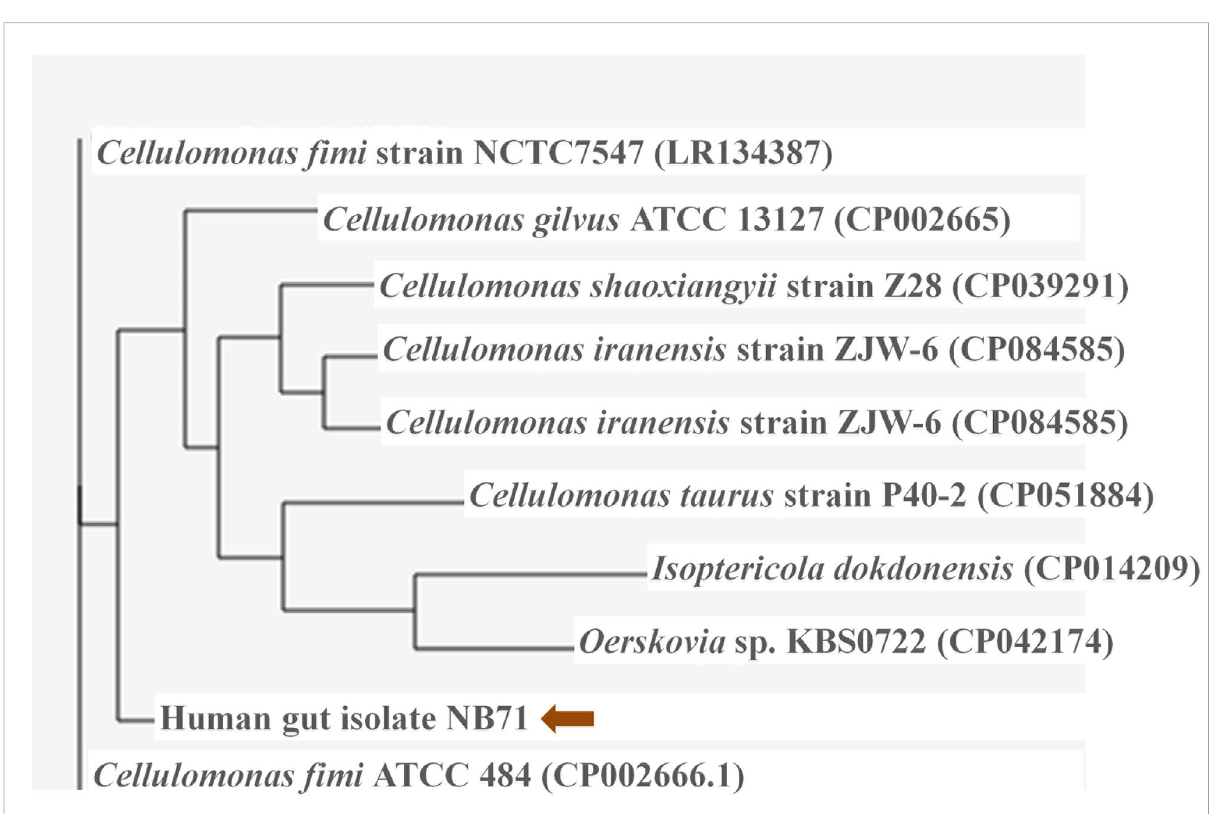
FIGURE 3 Phylogenetic assessment of the genome of Cellulomonas sp. HM71 with the genomes of Cellulomonas species. The phylogenetic relationship of the gut bacterial isolate strain HM71 was assessed with other Cellulomonas genomes using M1CR0B1AL1Z3R webserver (https://microbializer. tau.ac.il/). The online tool extracts ORFs, detects OGs, extracts OG sequences, infers a core proteome, and reconstructs the species phylogeny. The tree was drawn by taking Maximal e-value cutoff: 0.01; Identity minimal percent cutoff: 80.0%; Minimal percentage for core: 100.0% with no